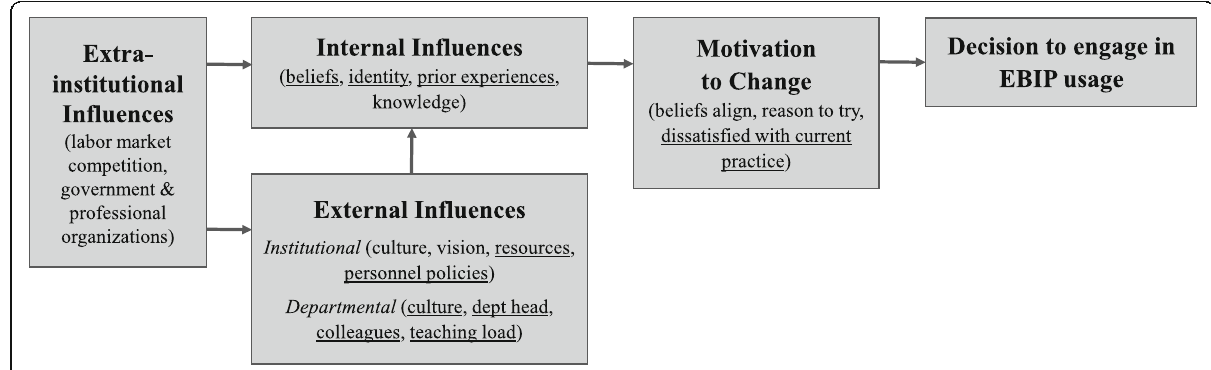
Fig. 1 Model for faculty ’ s decision-making process on using EBIPs. Underlined terms were included in the FIBIS instrument and measured in this study. (Note: arrows indicate theoretically-based relationships, not empirically tested